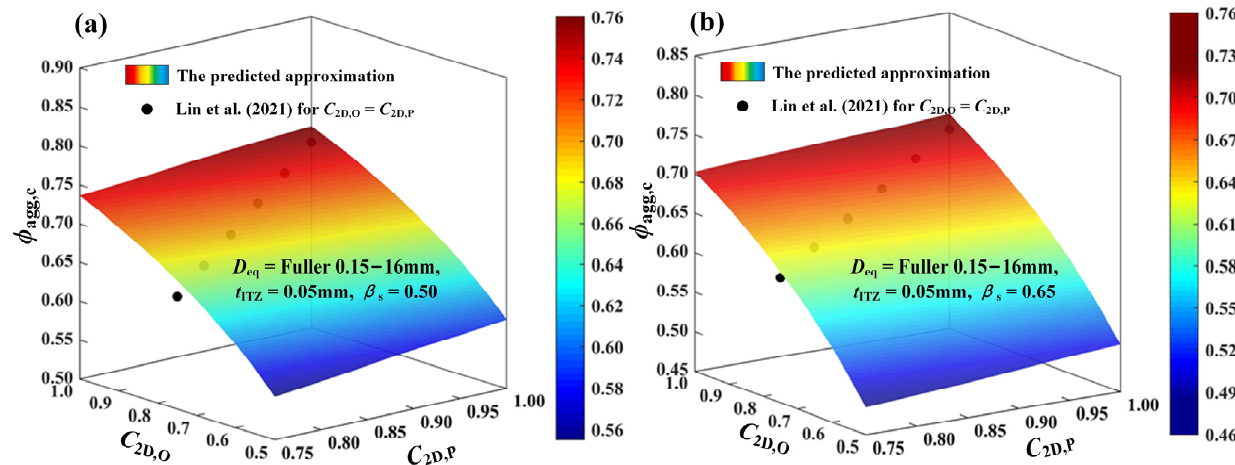
Figure 16. Comparisons of the predicted results of φ agg,c in the work with the numerical results of φ agg,c predicted by the formula in [18] ( a ) β s = 0.50; ( b ) β s = 0.65.